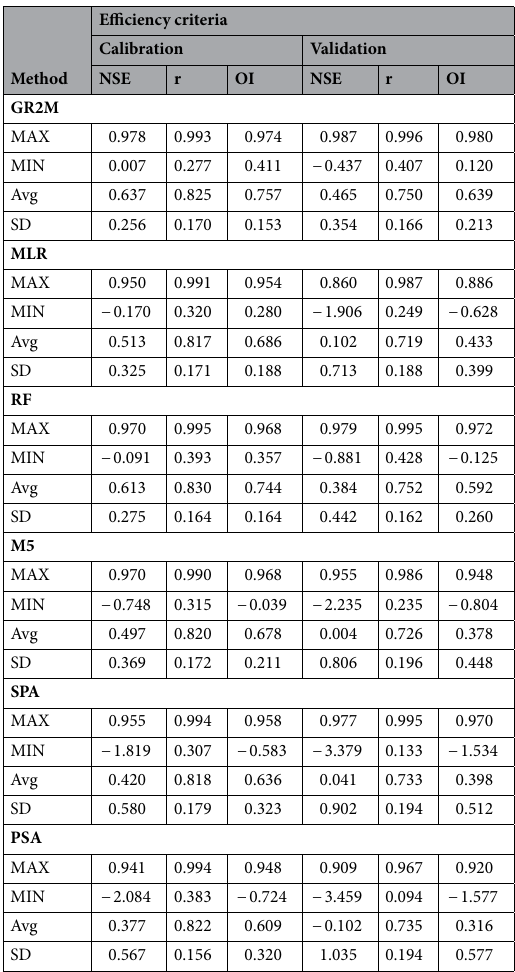
Table 5. The performance comparison of applying the estimated X 1 and X 2 values in the GR2M model with 6 methods. Remark: MAX = Maximum; MIN = Minimum; Avg = Average; SD = Standard